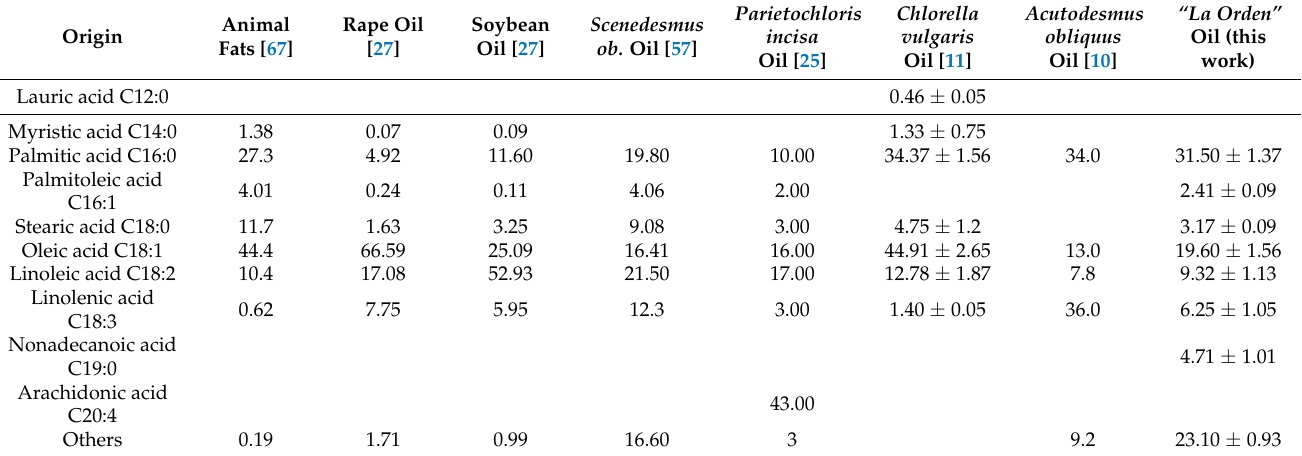
Table 6. Comparison of the major fatty acid composition of microalgae with other feedstocks published by other workers ([10]: Yun et al., 2016; [11]: El-Sheekh et al., 2019; [25]: Bigogno et al., 2002; [27] Mart í nez et al., 2014; [57]: Ho et al., 2012; [67]: Encinar et al.,